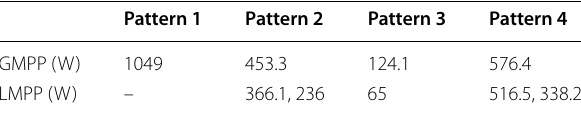
Table 4 Power at GMPP and LMPP under the four different shading